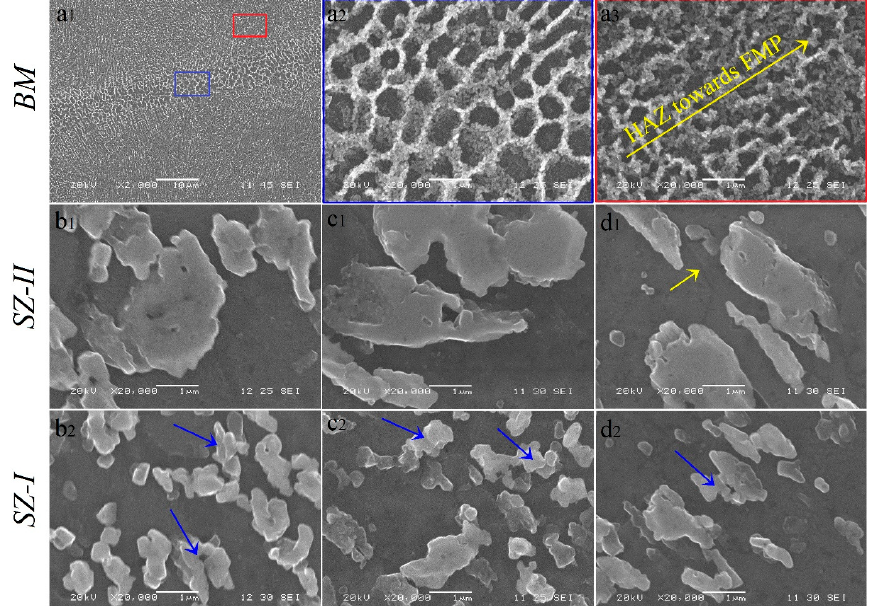
Figure 13. ( a ) SEM micrographs of as-built L-PBF AlSi10Mg at different magnification. The higher magnification of zones indicated by both blue and red rectangles in ( a1 ) are shown in ( a2 ) and ( a3 ), respectively. ( b1 – d1 ) SEM images of SZ-I and ( b2 – d2 ) SZ-II in 1–3 pass FSPed samples. The yellow arrow in SZ-II of the 3-pass sample ( d1 ) shows the grain boundary pinned by Si particles. Blue arrows in images related to SZ-I refer to the coalescence of Si particles during the growth.